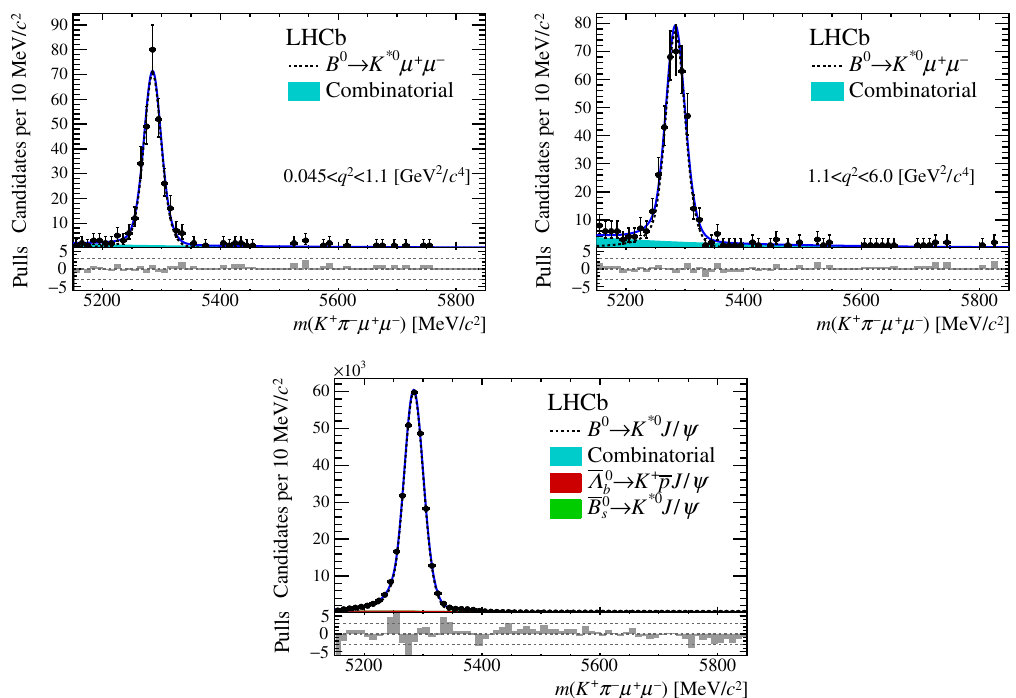
Figure 6 . Fit to the m ( K + (cid:25) (cid:0) (cid:22) + (cid:22) (cid:0) ) invariant mass of (top) B 0 ! K (cid:3) 0 (cid:22) + (cid:22) (cid:0) in the low- and central- q 2 bins and (bottom) B 0 ! K (cid:3) 0 J= ( ! (cid:22) + (cid:22) (cid:0) ) candidates. The dashed line is the signal PDF, the shaded shapes are the background PDFs and the solid line is the total PDF. The (cid:12)t residuals normalised to the data uncertainty are shown at the bottom of each distribution.